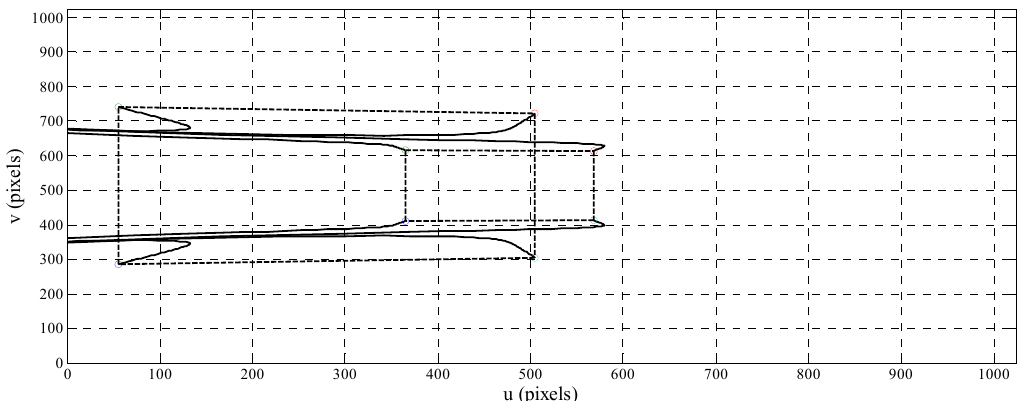
Figure 17. Case 2: Where the object leaves the field of view of the camera. Figure 18. Case 2: Evolution of the robot trajectory in the image plane.